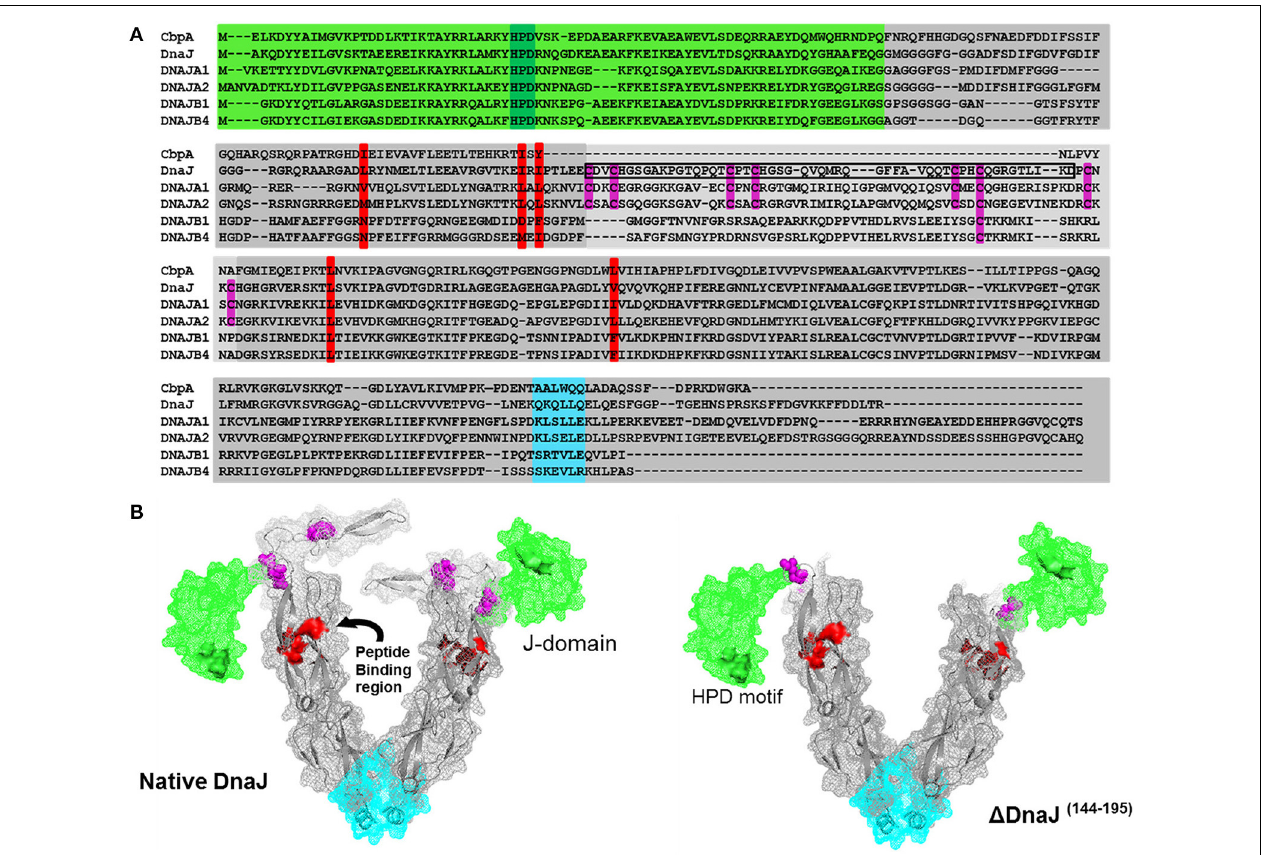
FIGURE 1 | Sequence alignment of the two most abundant human and bacterial J-proteins. (A) Amino-acid sequence alignment of the two most abundant Hsp40-like J-proteins in Escherichia coli bacteria CbpA and DnaJ, and the four most abundant Hsp40s in human: the type I J-proteins DNAJA1 and DNAJA2 and type II J-proteins DNAJB1 and DNAJB4. The conserved N-terminal J-domain (light green) with the conserved HPD motif (deep green) is followed by a G/F rich hinge region. In DnaJ, DNAJA1 and DNAA2, this is followed by a Zinc binding domain (light gray) with four pairs of highly conserved cysteines (purple), which are absent in CbpA, or different in DNAJB1 and DNAJB4. This is followed by a C-terminal peptide-binding domain (PBD) (dark gray) with the residues involved in peptide binding groove